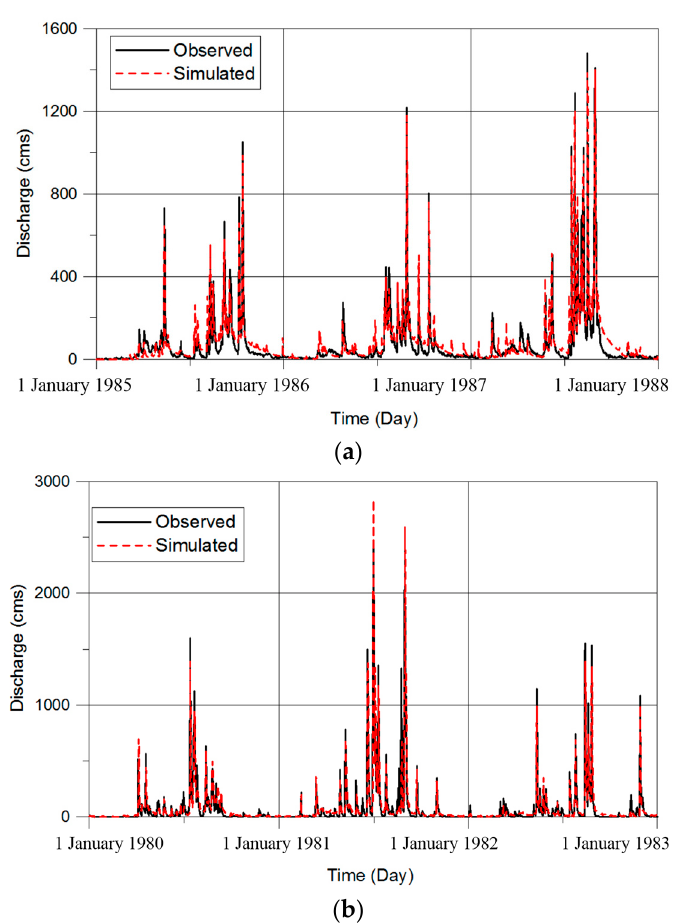
Figure 7. Calibration and validation of the Soil and Water Assessment Tool (SWAT) model in the Soyang Dam upper basin. ( a ) Calibration on JFM and AMJ; ( b ) validation on JFM and AMJ.